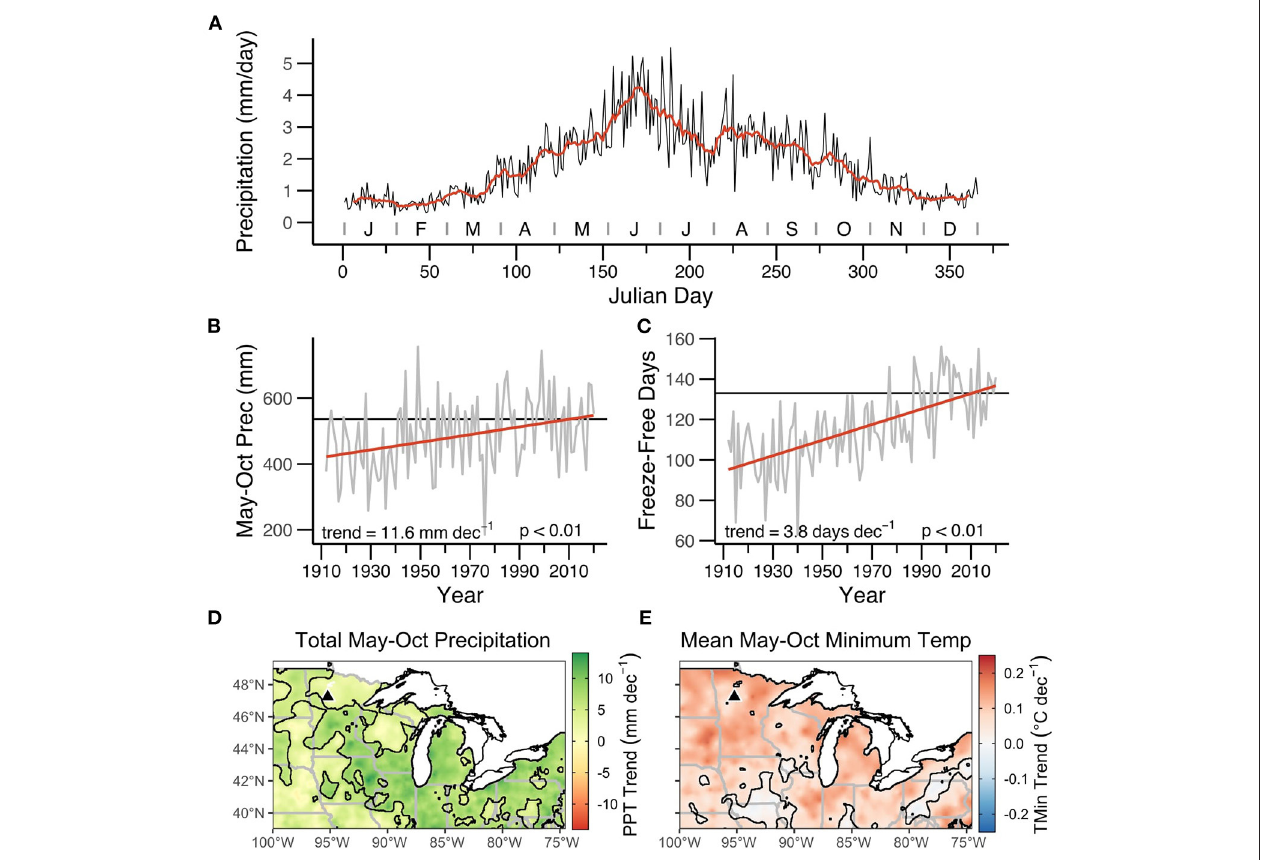
FIGURE 1 | Characteristics of climatology and change at Itasca State Park. Mean daily precipitation (black line) and 11-day moving average precipitation (red line) for the period 1912–2020 (A) . Timeseries (gray) and linear trend (red), and 1991–2020 mean (black) for warm-season (May–October) precipitation and freeze-free season length (days; 0 ◦ C minimum temperature threshold) for 1912–2020 (B,C) . Regional-scale linear trends in CLIMGRID warm season (May–October) precipitation (D) and minimum temperature (E) for 1895–2020, with the black contour encompassing areas where trend test p -values were <